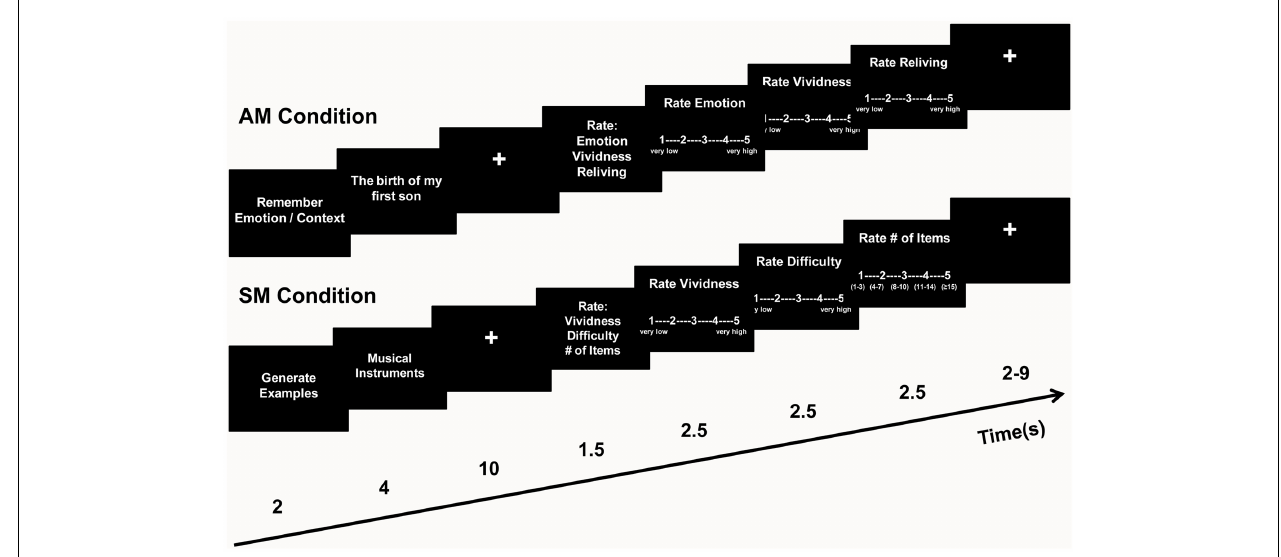
Vividness, and Reliving on five-point scales. During the control Semantic Memory (SM) condition, participants generated as many exemplars as possible from a given semantic category, and then rated each of them for Vividness, Difficulty, and Number of Items on five-point